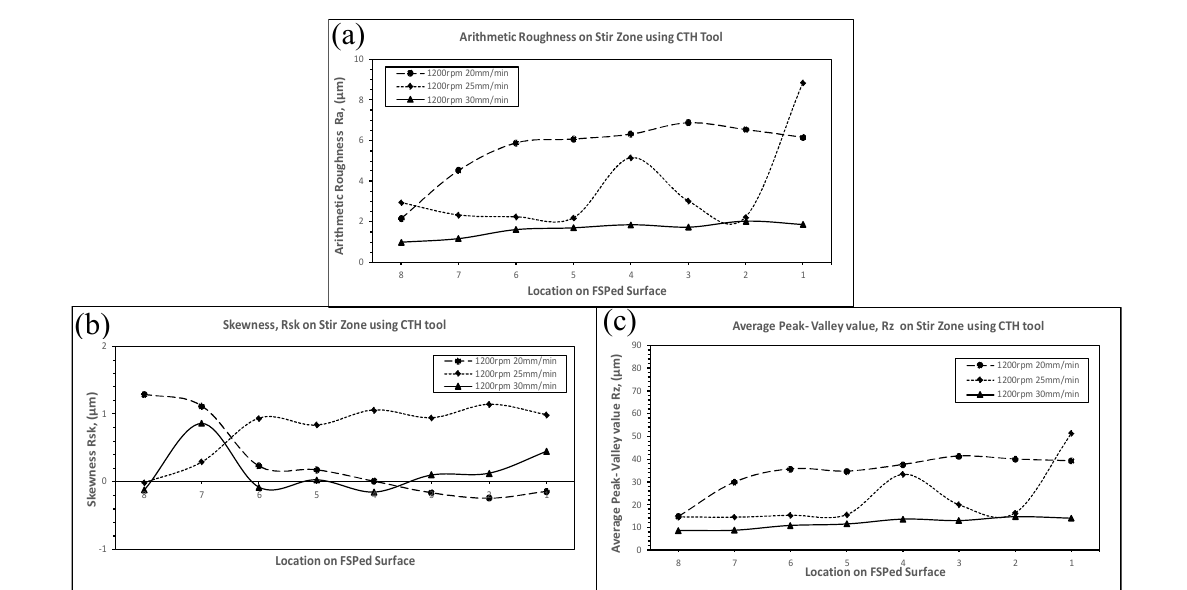
Figure 12. ( a ) Arithmetic roughness, Ra, ( b ) skewness, Rsk, and ( c ) average peak-valley, Rz, value for FSP using 1150 rpm and CTH tool at different feed rates.